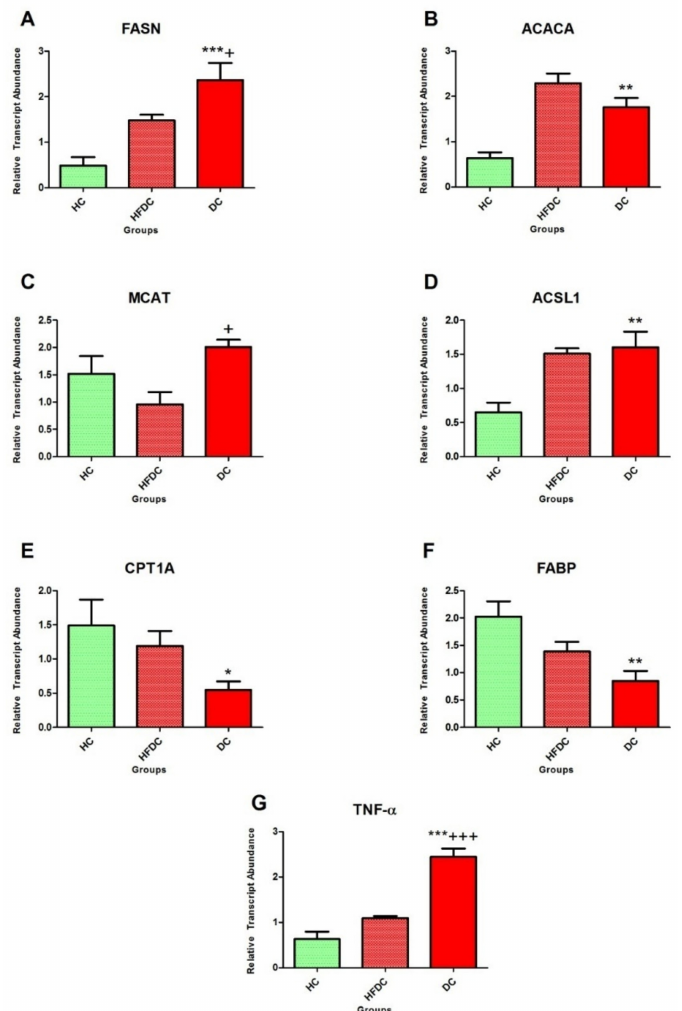
Figure 5. Modulation of expression in fatty acid metabolism and inflammatory genes. Animals from the HC group were fed on normal diet while HFDC and DC groups were on high fat diet. DC group was treated with STZ 35 mg / kg body weight (ip). ( A – F ) shows expression profiles of the FASN , ACACA , MCAT , ACSL1 , CPT1A , FABP genes of fatty acid metabolism and Figure G shows expression of the TNF- α gene. Results are denoted as mean ± SD ( n = 3 and the reactions were performed in duplicates). * p ≤ 0.05, ** p ≤ 0.01 and *** p ≤ 0.001 when compared with the HC group and + p ≤ 0.05, +++ p ≤ 0.001 when compared with the HFDC group (Dunnett’s multiple comparison